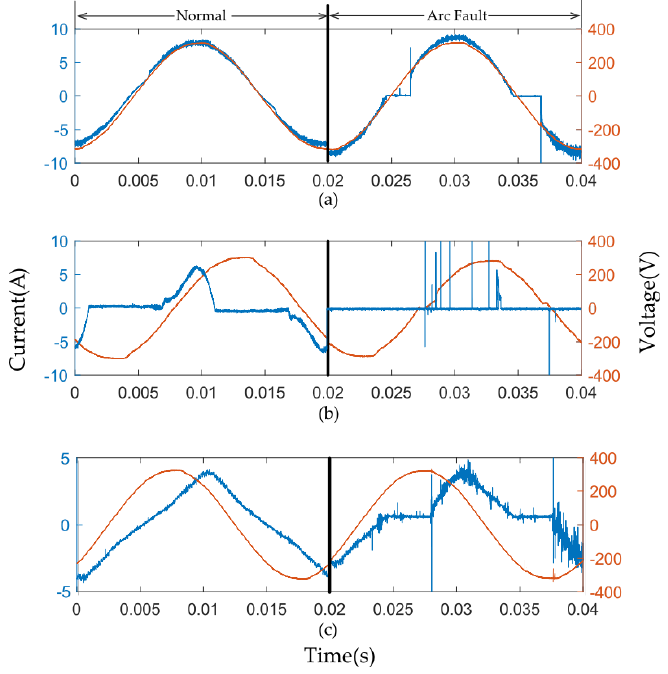
Figure 1. Current waveforms under different loads. ( a ) Halogen lamp. ( b ) Computer host. ( c ) Electric drill.